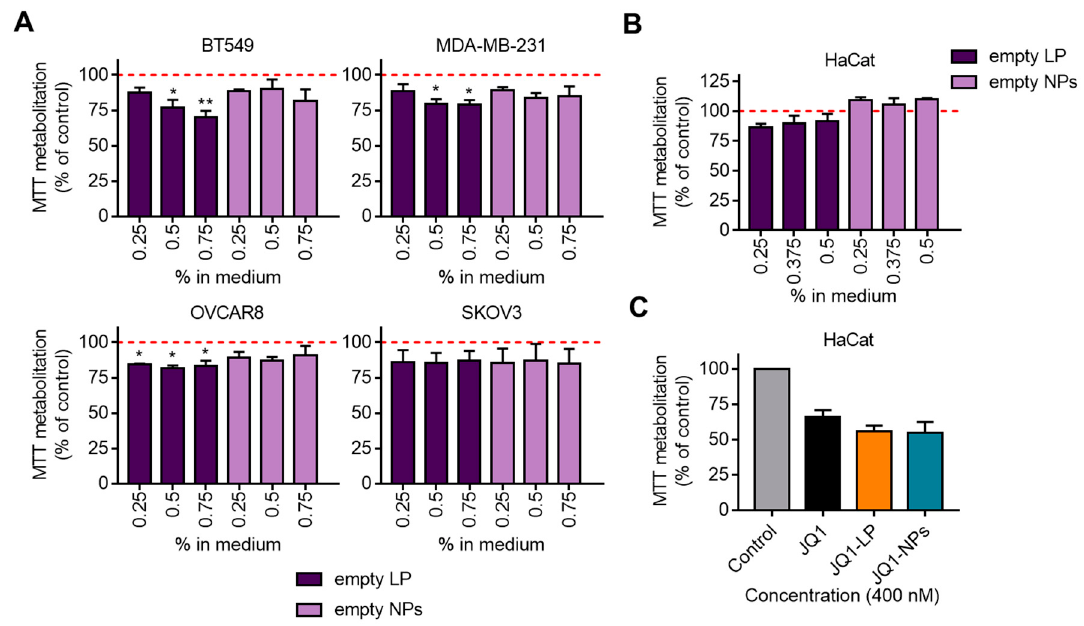
Figure 4. Evaluation of toxicity of empty encapsulations and their effect in normal-keratinocyte cells. ( A ) Cells treated with non-loaded formulations with similar medium percentage (%) relative to the previous proliferation assay (with JQ1 encapsulation) (0.25% in medium = 250 nM; 0.5% in medium = 500 nM; 0.75% in medium = 750 nM). ( B ) Human keratinocyte cell line HaCat treated with empty liposomes and empty nanoparticles (0.25% in medium = 250 nM; 0.375% in medium = 375 nM; 0.5% in medium = 500 nM). ( C ) HaCat cells were treated with JQ1-free, JQ1-LP and JQ1-NPs at 400 nM. * p ≤ 0.05 and ** p ≤ 0.01.